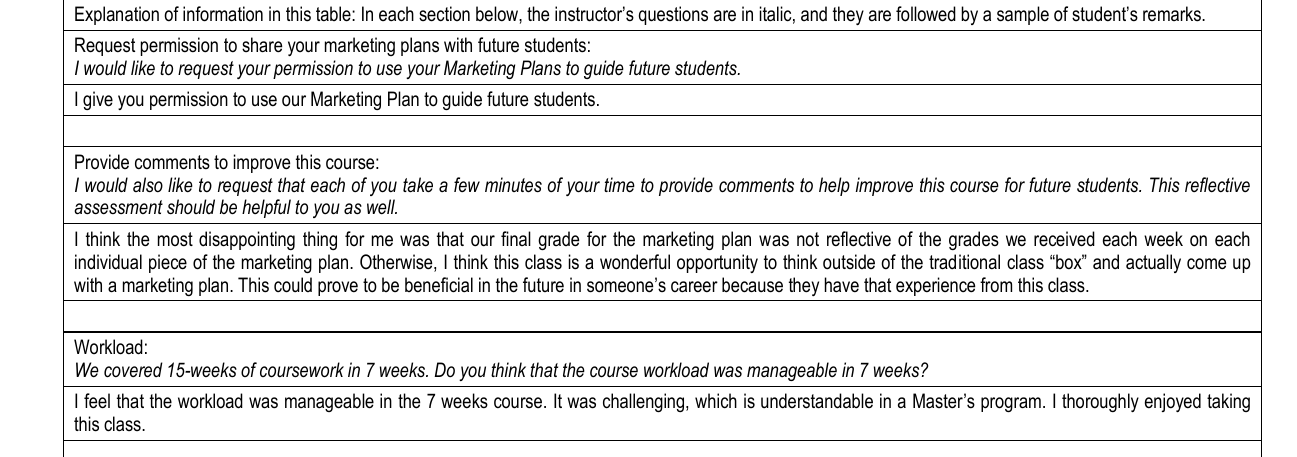
Table 8. Selected students ’ comments on different aspects of MKT 640 Marketing Management